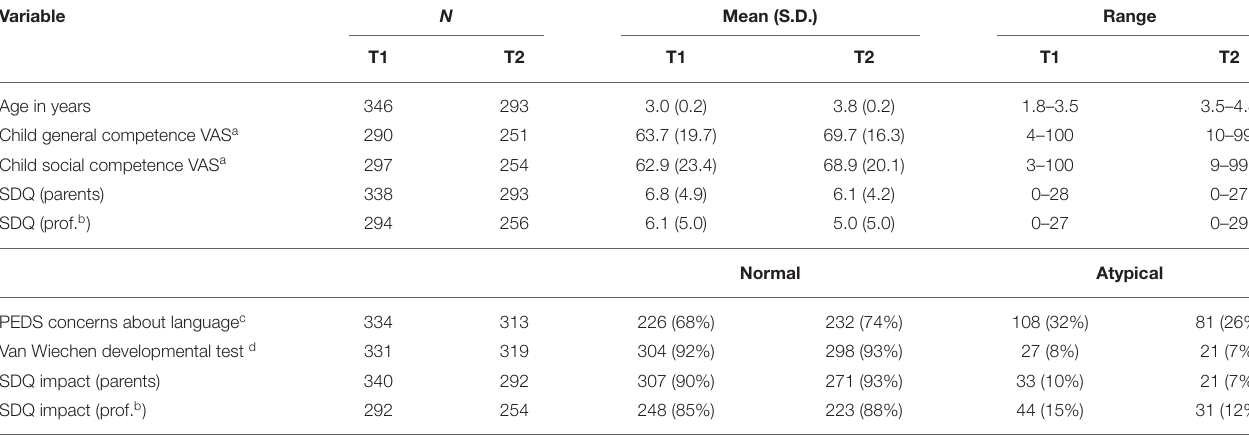
TABLE 1 | Descriptive statistics at baseline (T1) and follow-up